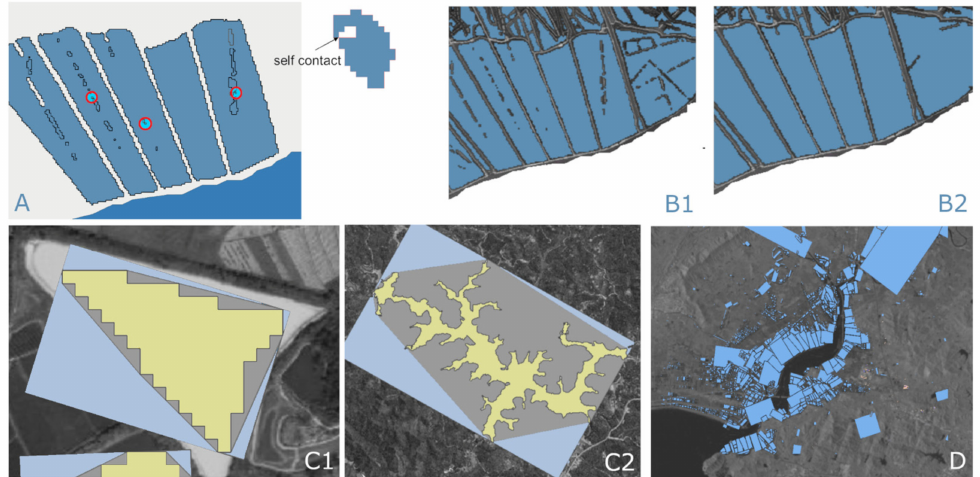
Figure 8. ( A ) Self-contacting polygon edges; ( B1 ) Holes in polygons and ( B2 ) Patched holes; ( C1 , C2 ) Compactness parameters: yellow—water polygon; grey—convex hull of the polygon; light blue— oriented minimum bounding box; ( D ) Result of the minimum oriented bounding box calculated for the aquaculture pond mapping